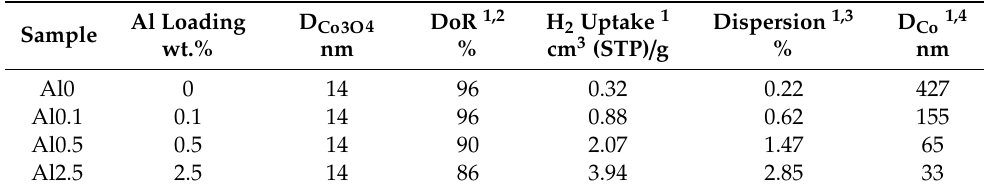
Table 1. Physicochemical characterization of used